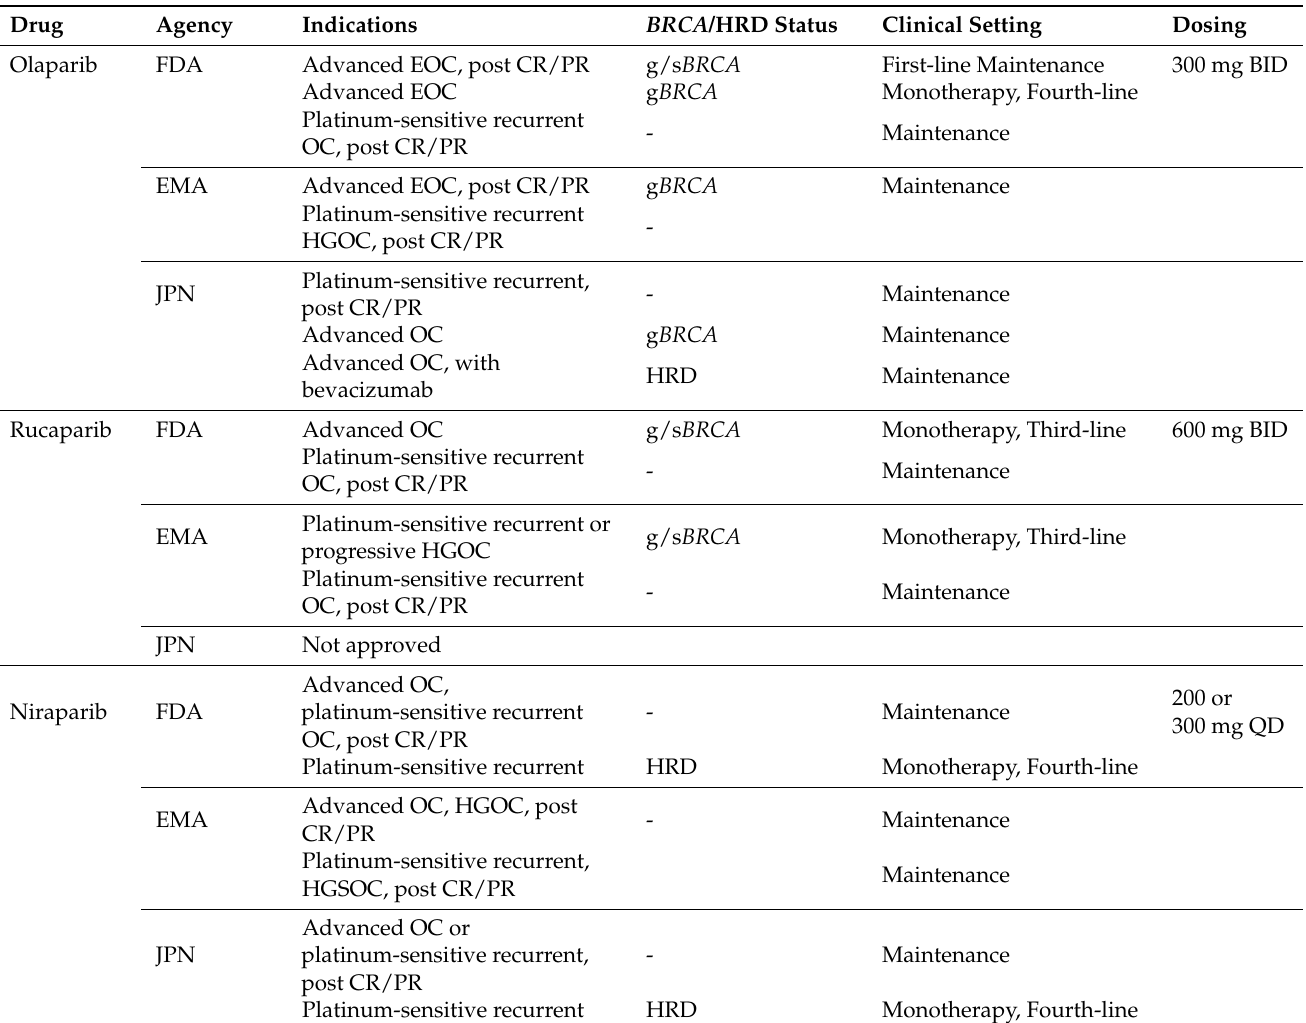
Table 4. Indication of PARP inhibitors for patients with epithelial ovarian